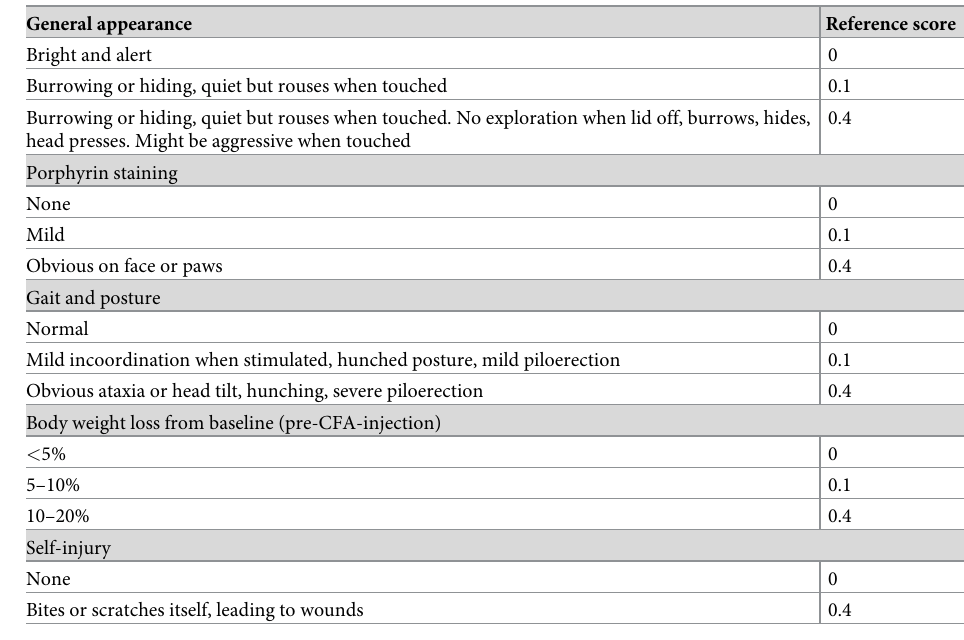
Table 2. Welfare